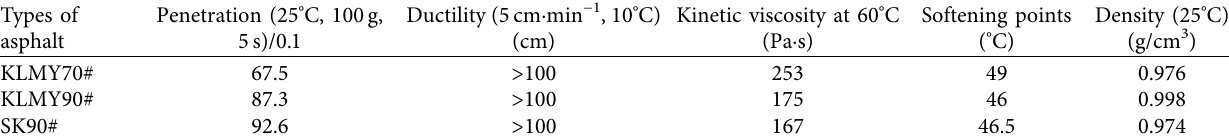
Table 1: Technique performance of matrix asphalt.